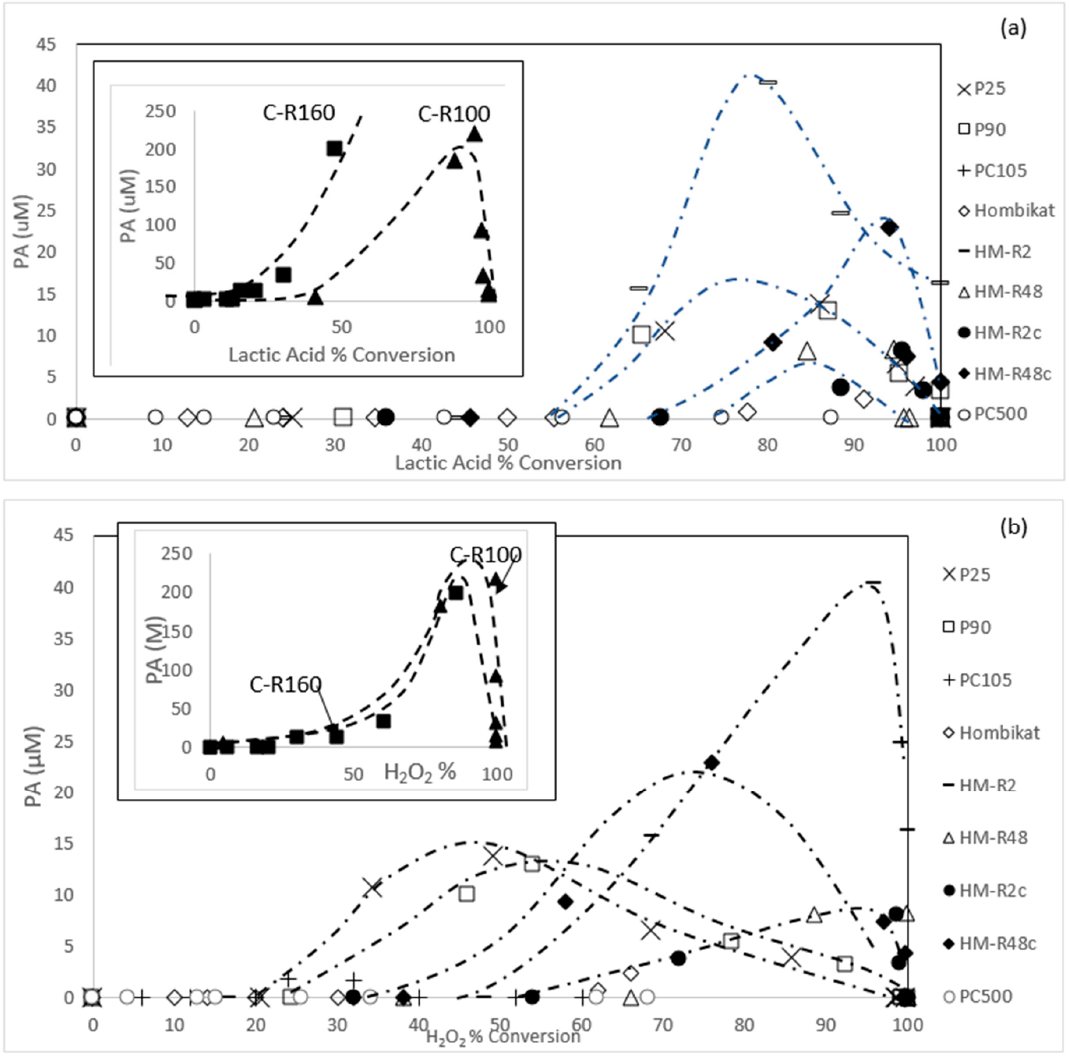
Figure 7. Pyruvic acid concentration as a function of lactic acid conversion ( a ) and of H 2 O 2 conversion ( b